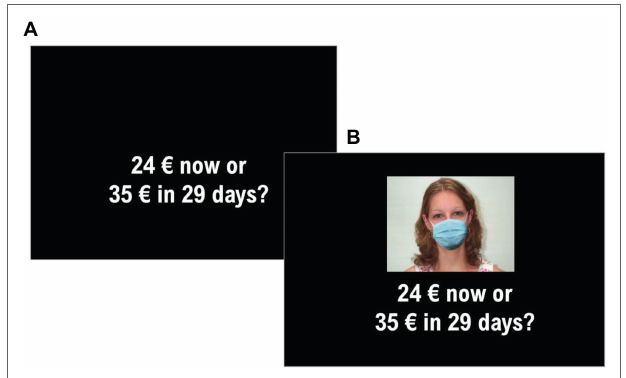
FIGURE 1 | Trial example in the “baseline” (A) and “proposer” block (B)